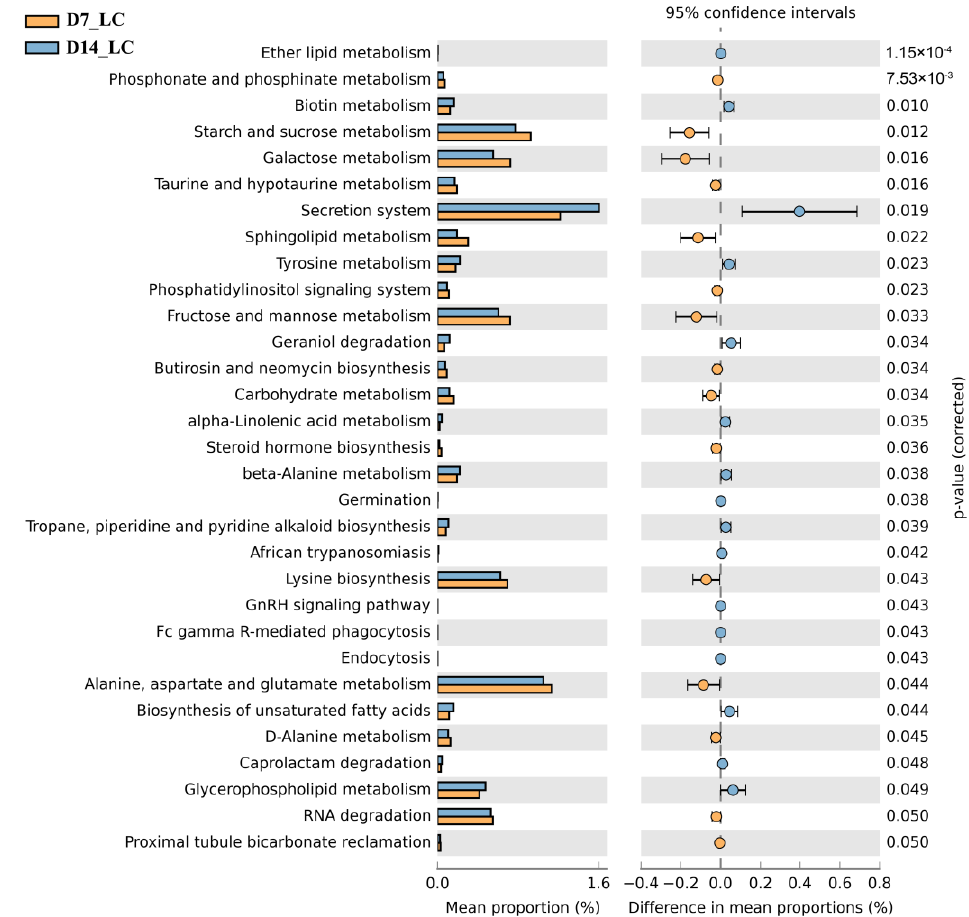
Figure 8. KEGG pathway analysis of intestinal microbial metabolism in crabs after low concentration FF exposure. FF